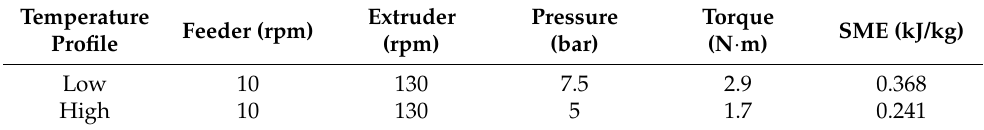
Table 4. Processing conditions for pure PLA.